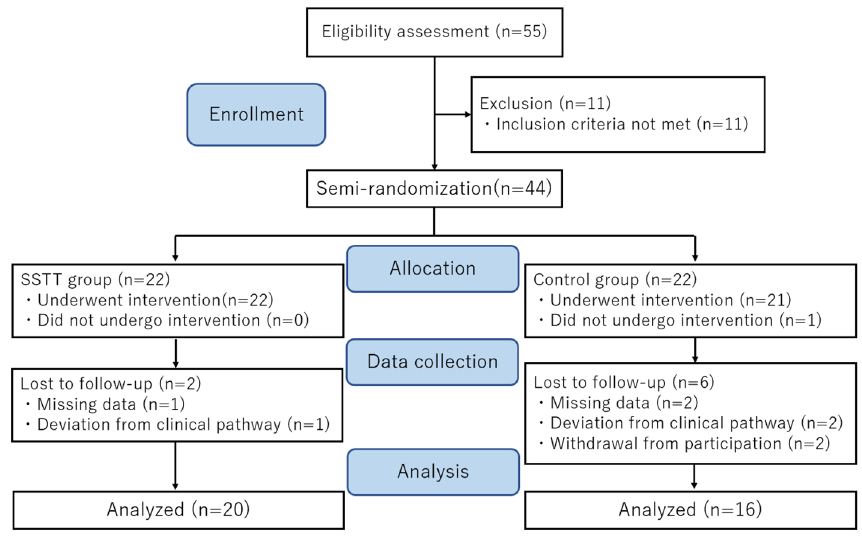
Figure 2. CONSORT flow diagram showing the enrollment and progress of the study participants. Table 1. Comparison of basic characteristics between SSTT and control groups.